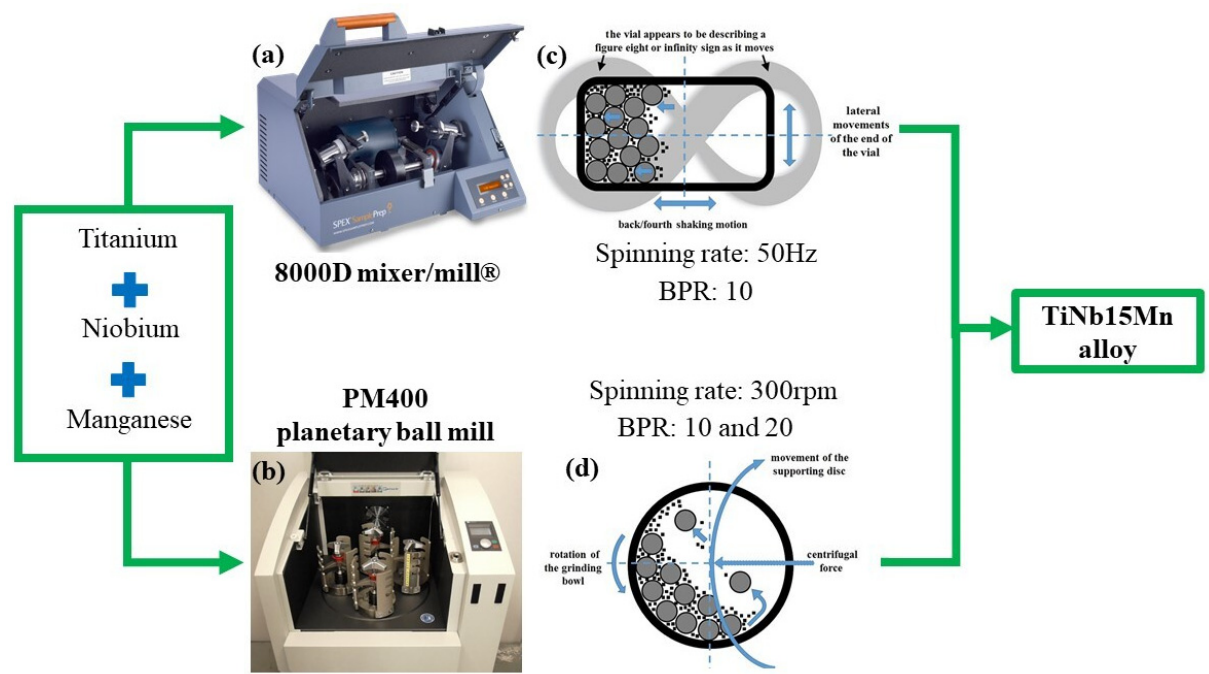
Figure 1. Schema of the mechanical alloying process carried out in both 8000D mixer/mill ® and PM400 planetary ball mill for the TiNbMn system.